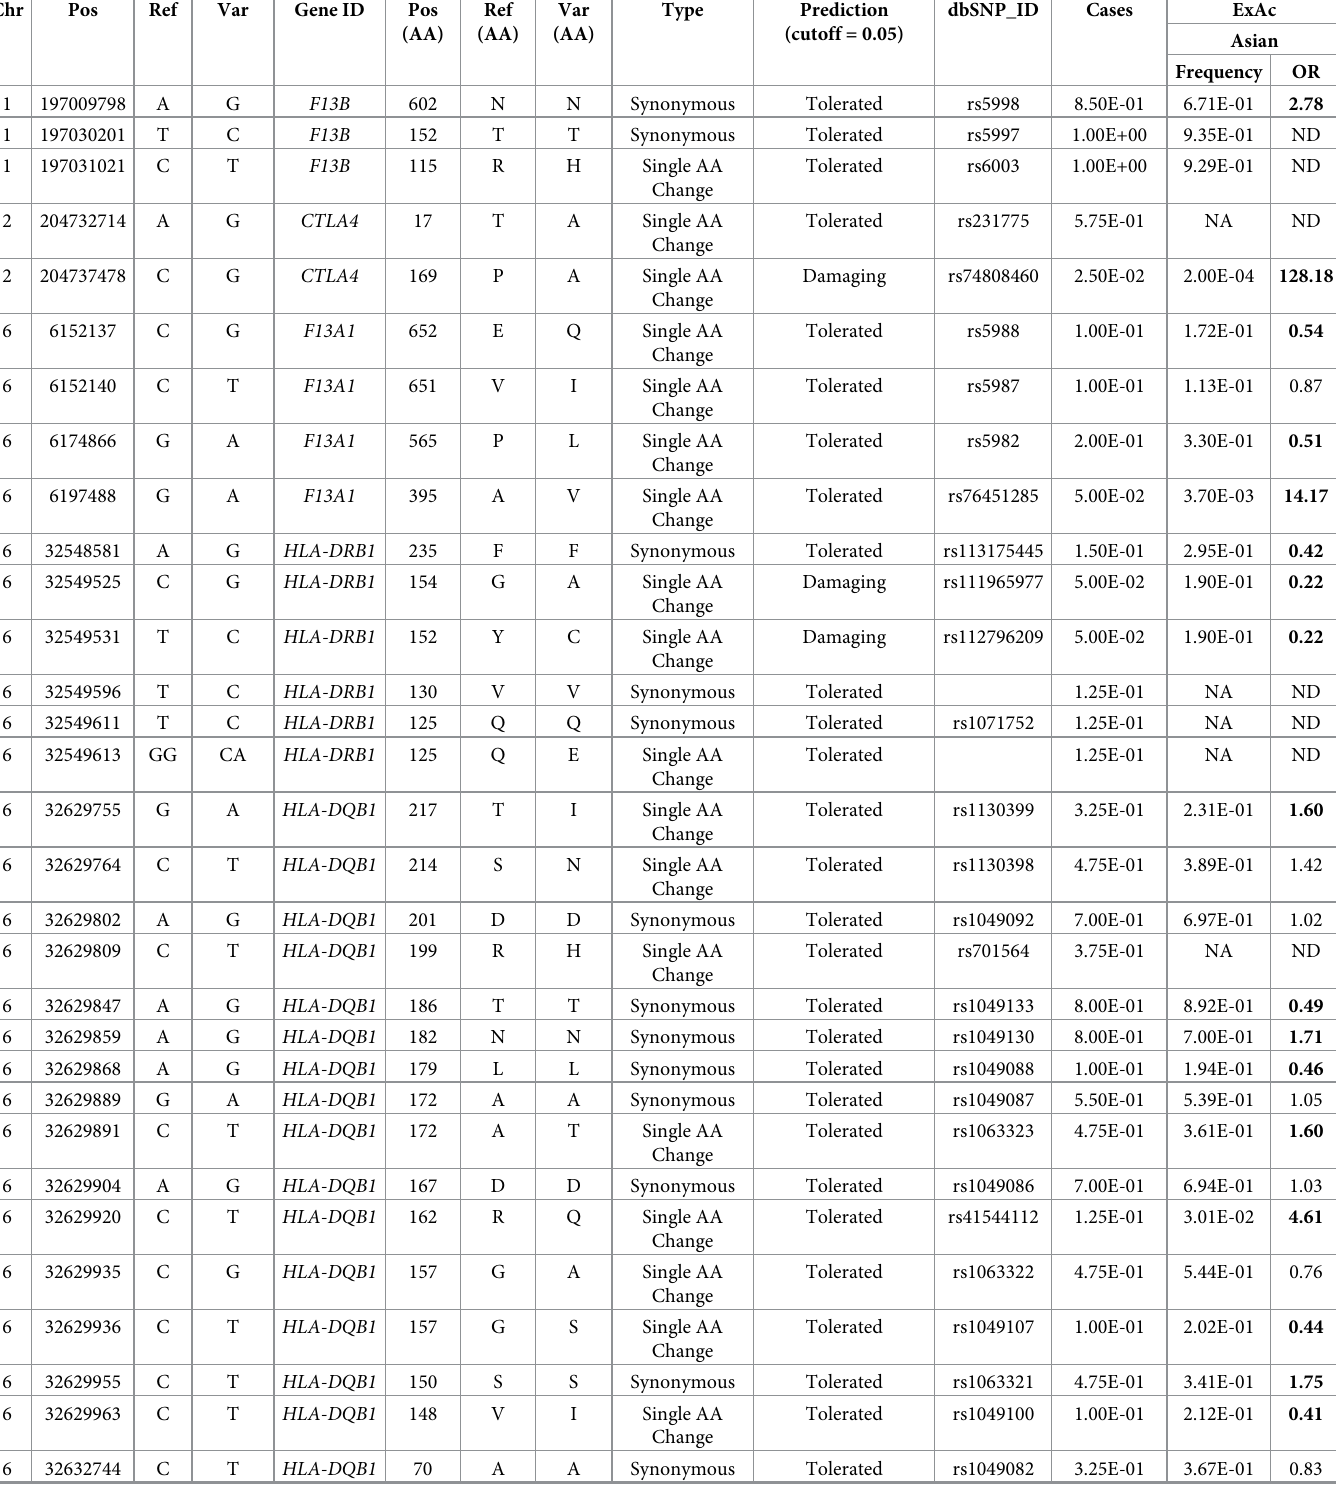
Table 2. F13A1 , F13B , CTLA4 , HLA-DRB1 , and HLA-DQB1 variants in autoimmune FXIII deficiency